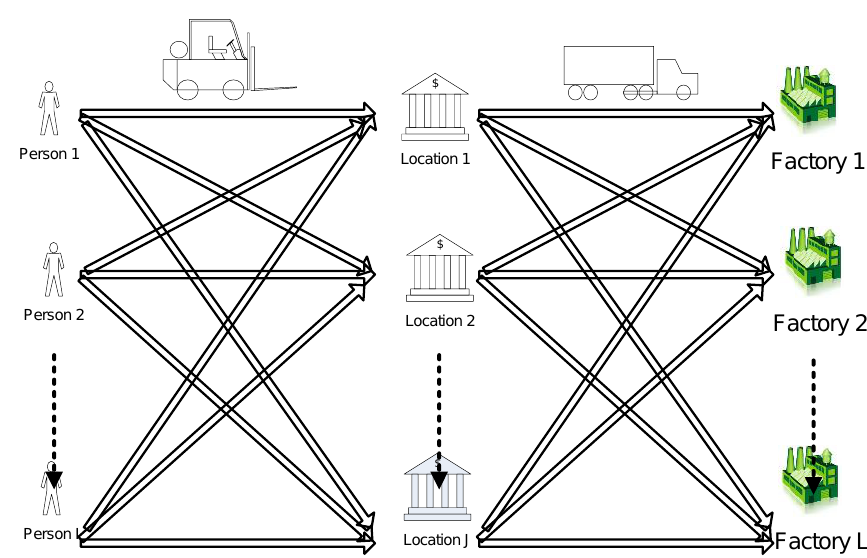
Figure 1. Oil palm transportation activities at each level.